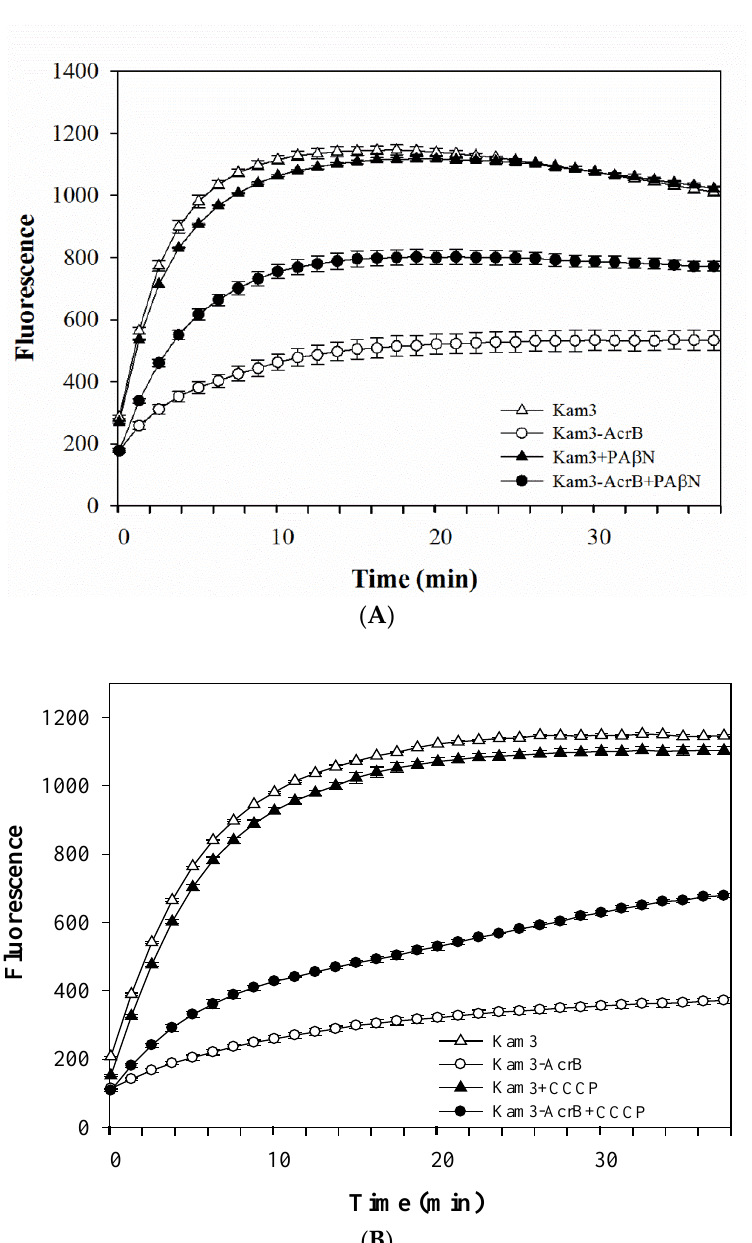
Figure 1. H33342 accumulation in E. coli Kam3-AcrB and Kam3 in the presence of efflux pump inhibitor ( A ) PA βN , ( B ) CCCP. The fluorescence was recorded at excitation and emission wavelengths 360 and 460 nm, respectively, over 38 min of incubation time. Values are expressed as mean ± standard deviation (SD) ( n = 3).